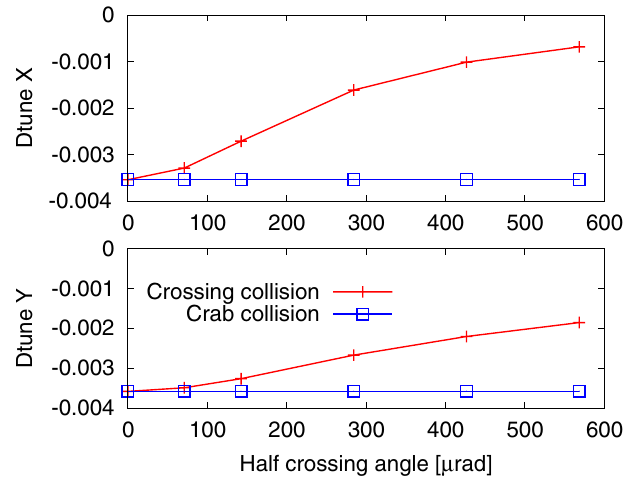
FIG. 28. (Color) Horizontal tune shift (top) and vertical tune shift (bottom): crossing collision with one beam-beam element at IP5(H) and horizontal crossing (red); full crab collision with the same beam-beam element at IP5(H) and both beam crabbed (blue). The crab crossing tune shift is found to be the same as the one for the head-on collision case.